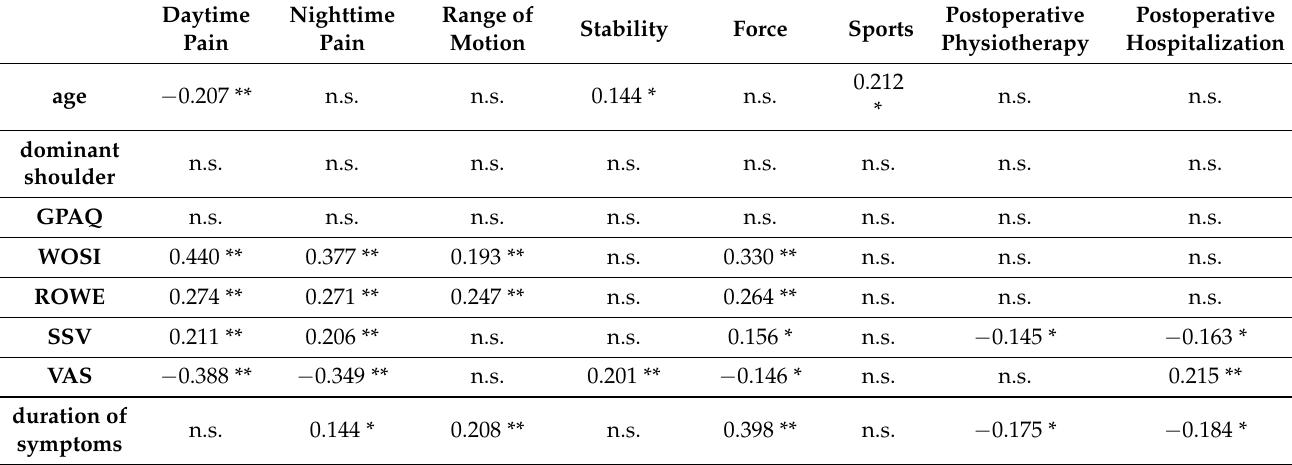
Table 2. Correlation coefficient of the ranking of factors and patients’ demographics and scores (* p ≤ 0.05, ** p ≤ 0.01, n.s. = no significance).